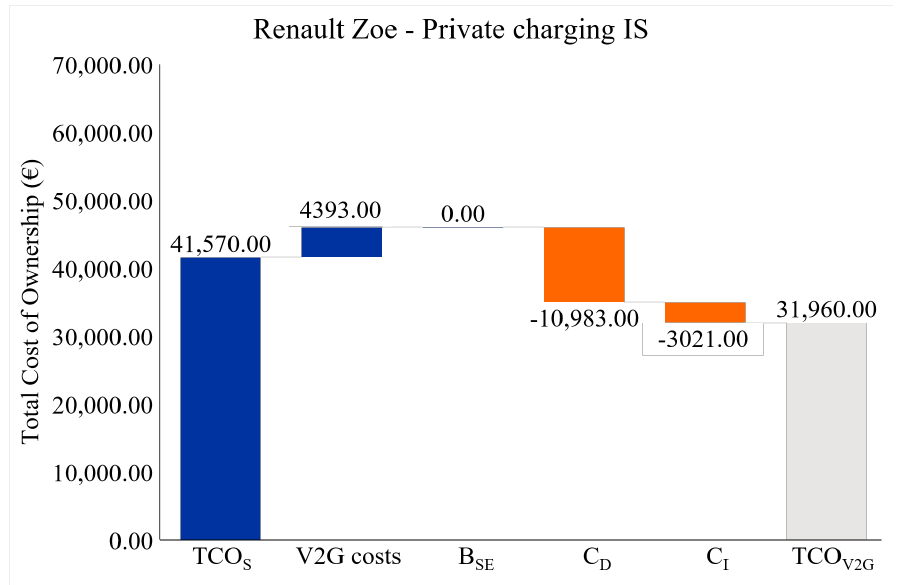
Figure A2. Standard and V2G TCO of a Renault Zoe in a private charging case providing IS ( TCO S = Standard TCO, B SE = benefit of saved electricity costs from the grid, C D = direct compensa- tion, C I = indirect compensation, TCO V 2 G = V2G TCO); source: own compilation).